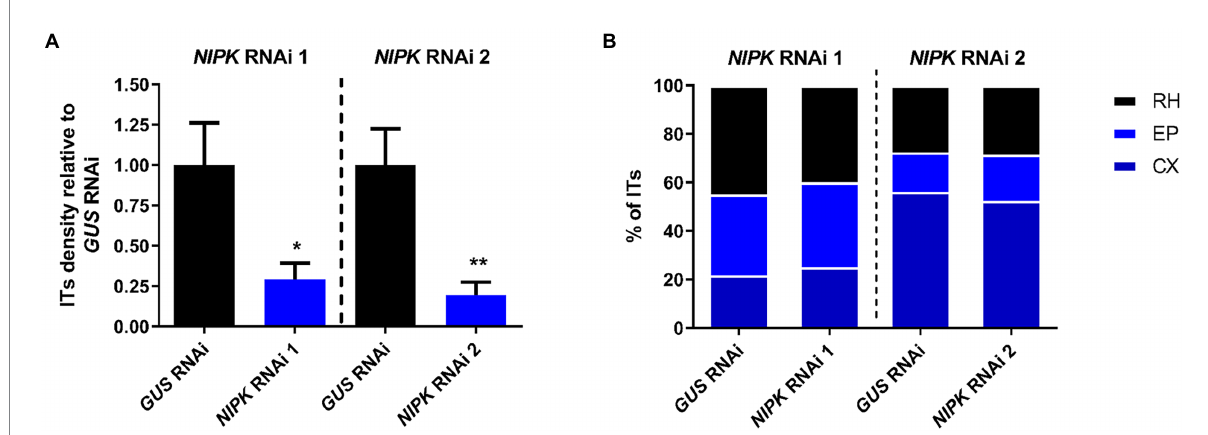
FIGURE 6 NIPK silencing affects formation, but not progression of ITs. GUS or NIPK RNAi composite plants were inoculated with Rhizobium etli CFN5X expressing DsRED. (A) ITs were visualized and quantified at 4 dpi and normalized by root length. Error bars represent SEM. Significant differences in a t -test are indicated with asterisks (*, p < 0.05; **, p < 0.01). (B) ITs were classified in three categories: RH, when just growth inside the root hair; EP when growth to epidermal cells (ending in the base of the trichoblast or in an adjacent epidermal cell); and CX for these reaching cortical cells. Percentages of ITs in each category are presented.